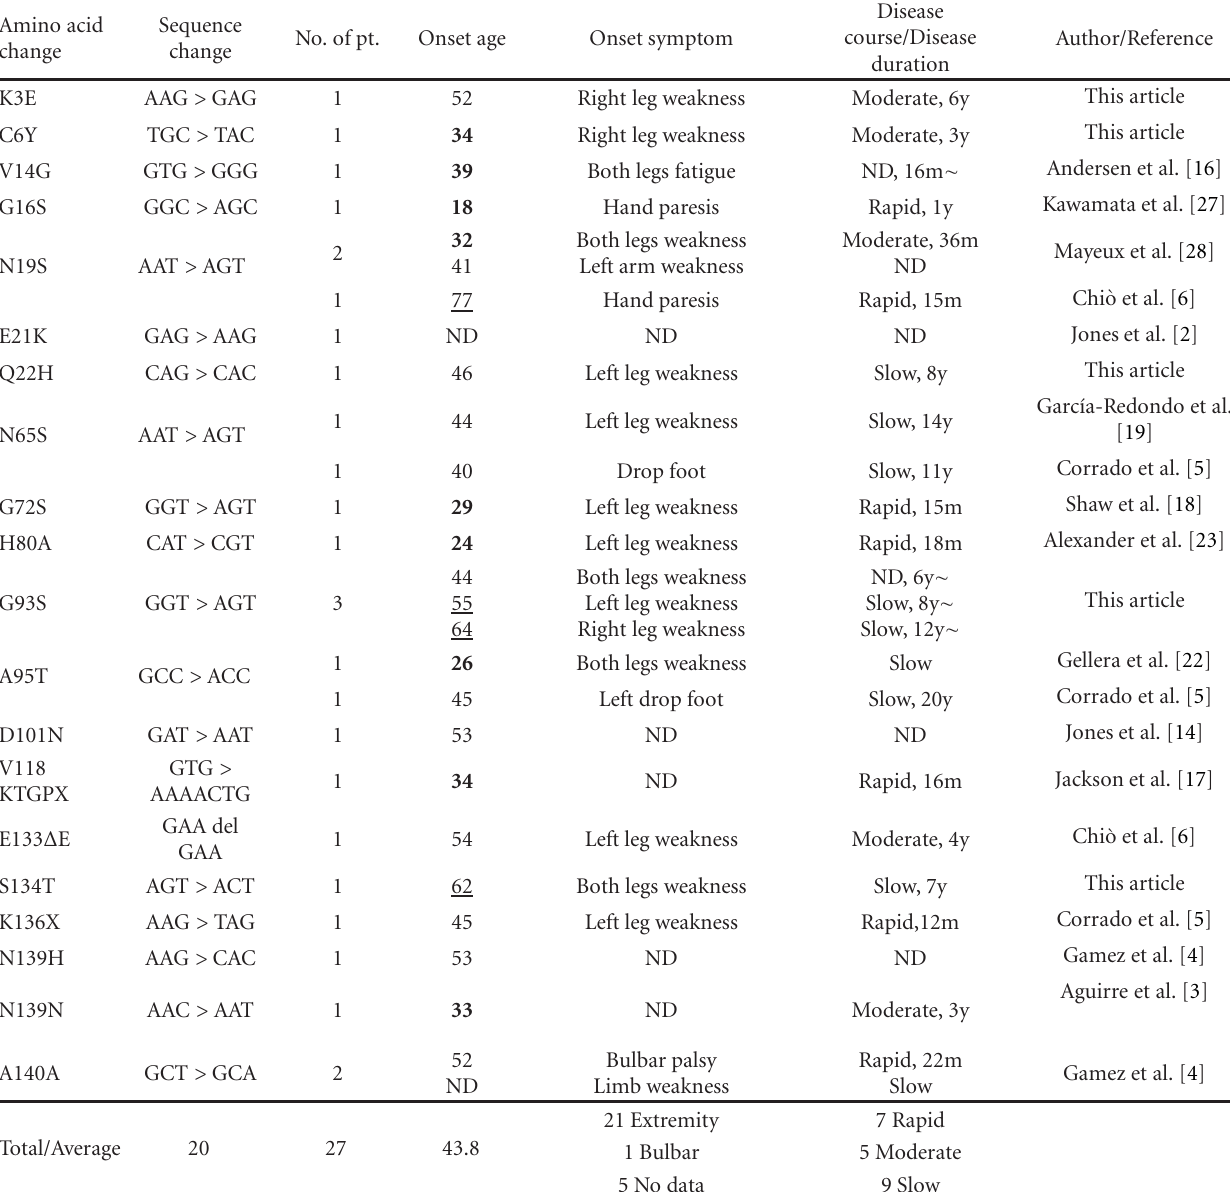
Table 3: Clinical characteristics of the SALS patients having SOD1